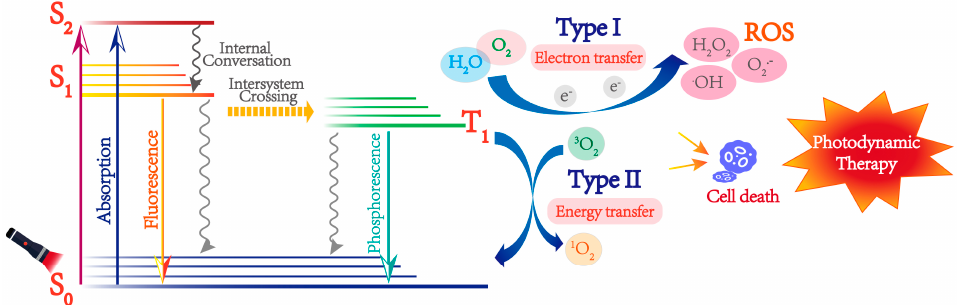
Figure 1. Schematic illustration of the modified Jablonski diagram of a PS in PDT [14]. Carbon dots (CDs) are a new type of carbon nanomaterials, with less than 10 nm in size, including carbonized quantum dots, graphene quantum dots, carbon nanodots, and carbonized polymer dots [15–19]. The carbon dots have a π - π conjugate structure, which is significantly different from the traditional inorganic quantum dots. Their core is com- posed of graphitized sp 2 hybrid carbon, and the shell is rich in organic functional groups, such as carboxyl group, aminyl group, hydroxyl group, etc., making the carbon dots